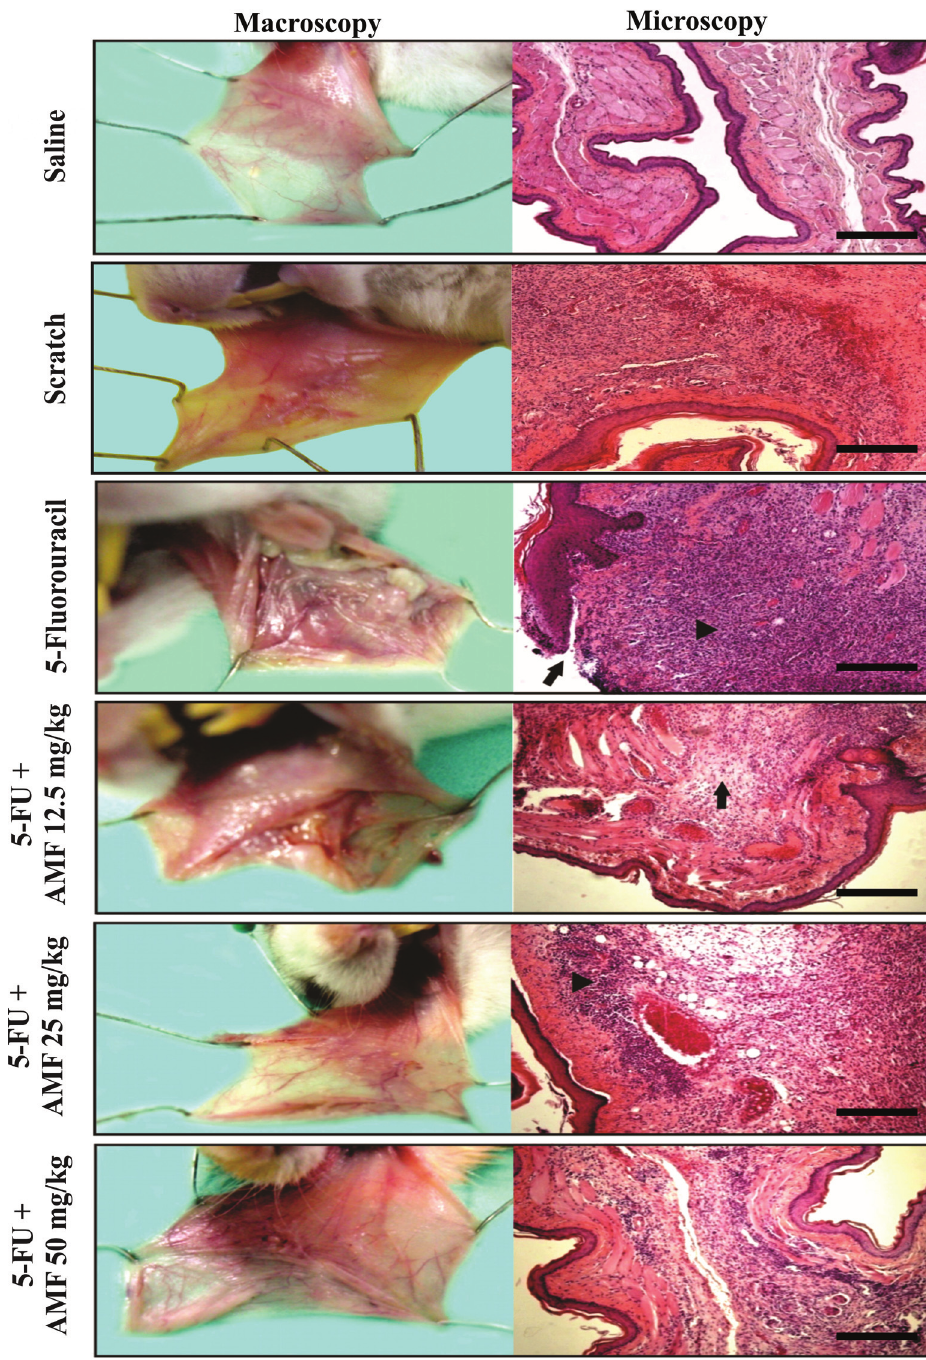
Figure 3. 5- fl uorouracil (5-FU) induced macroscopic and microscopic injury, which was prevented by amifostine. The saline-treated and scratch groups showed no sign of tissue damage. Conversely, 5-FU signi fi cantly induced tissue erythema, mucosal ulceration, abscesses, and hemorrhage versus the saline group. In addition, amifostine (AMF) protected the animals from the macroscopic and microscopic damage compared to the 5-FU group. Arrowheads indicate areas of in fl ammatory in fi ltration. Arrows denote edema and ulceration areas. Magni fi cation: 40 (cid:1) , scale bar: 500 m